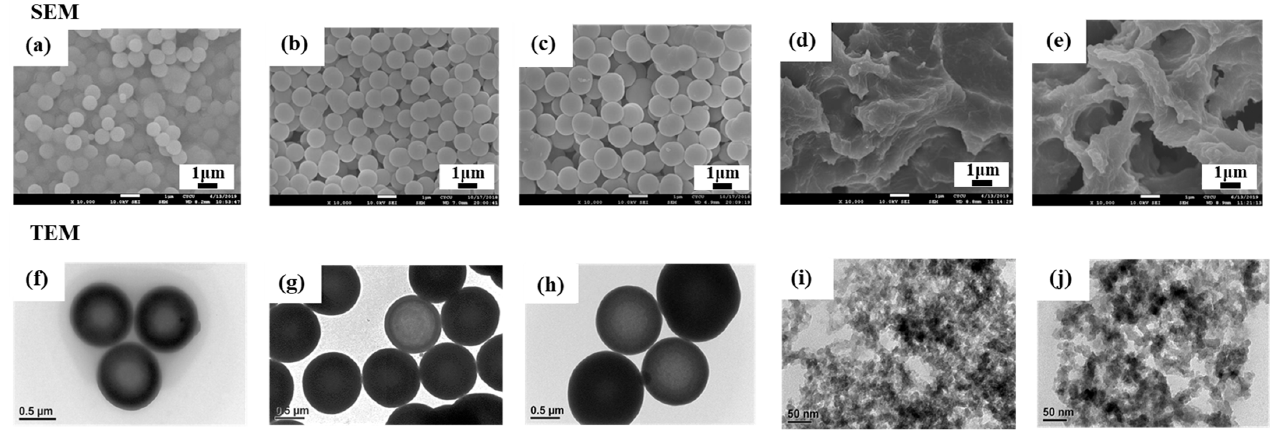
Figure 4. SEM for ( a ) A1, ( b ) A2, ( c ) A3, ( d ) M1, and ( e ) M2, as well as the transmission images of the TEM for ( f ) A1, ( g ) A2, ( h ) A3, ( i ) M1, and ( j ) M2.